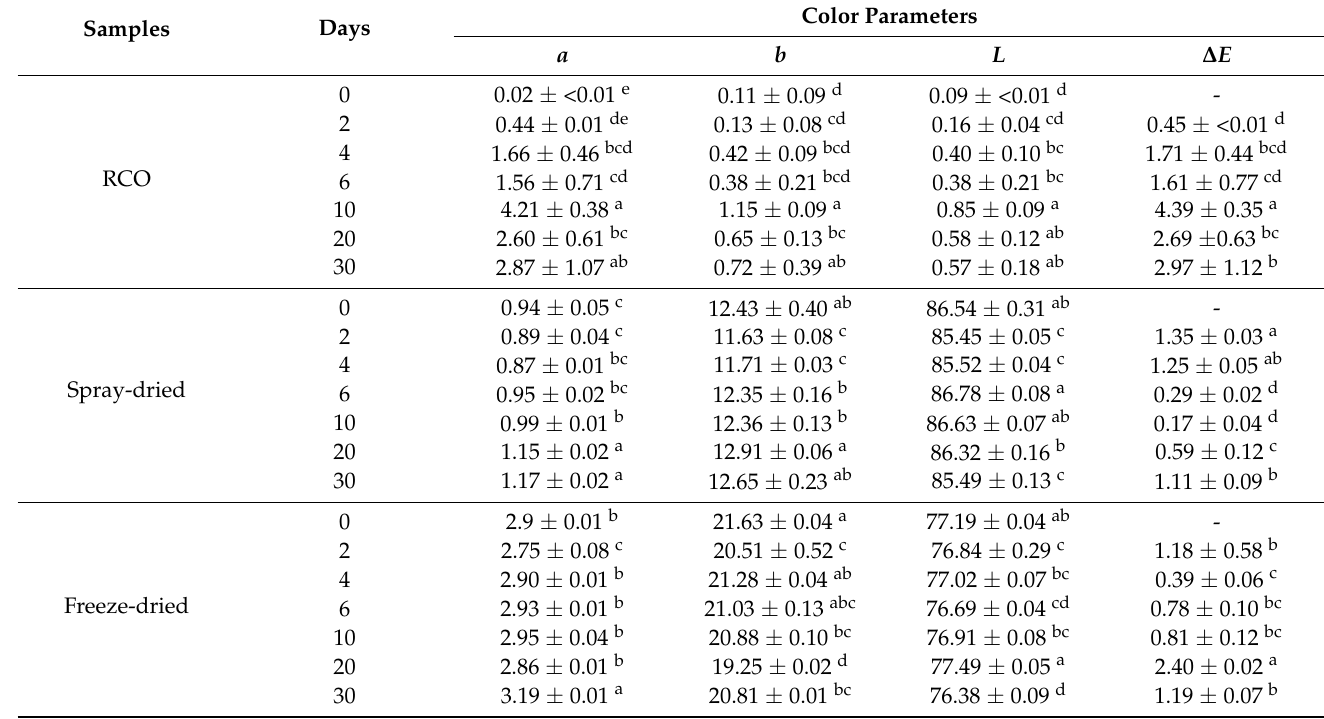
Table 2. Color parameters of the roasted coffee oil (RCO) and spray- and freeze-dried microcapsules over 30 days of storage at 25 ◦